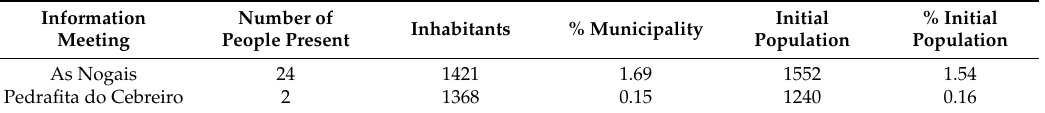
Table 5. Attendance at information meetings in the intensification